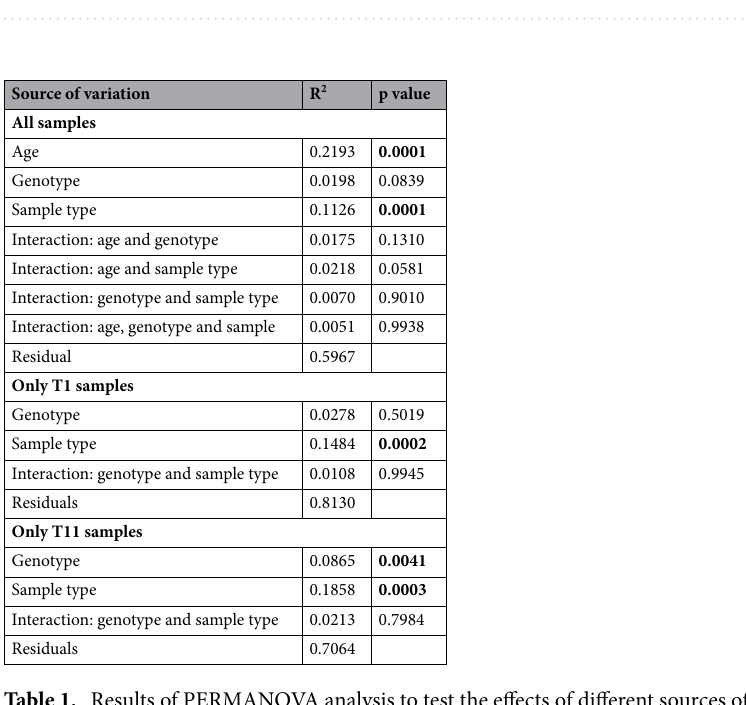
Figure 2. PCoA ordinations based on Bray–Curtis dissimilarity index. Ordination of all samples at T1 and T11. Shape of points indicates sample type: squares for faeces, circle for mucosa, and triangles for tumour. Empty shapes indicate wt samples, while solid/full shapes indicate Pirc samples; colour of points represents time (blue for T1 and red for T11).